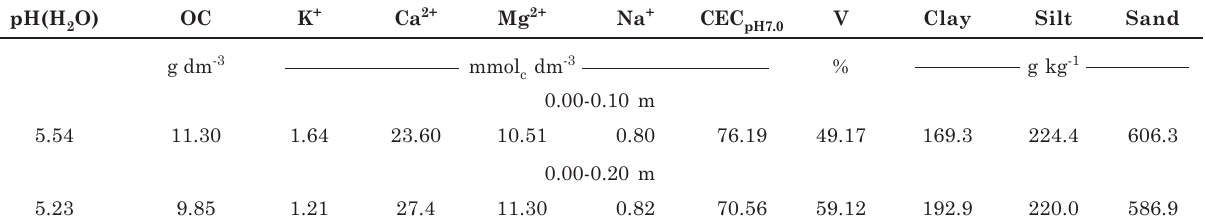
OC: organic carbon, V: base